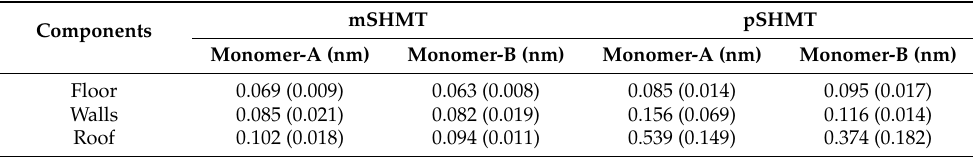
Table 2. RMSF average values and SDs (in parentheses) of the active-site components of the two monomers in mSHMT and pSHMT.